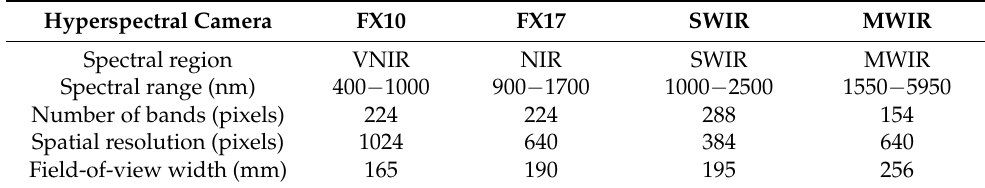
Table 1. Spectroscopic characteristics of the hyperspectral cameras used for the study.